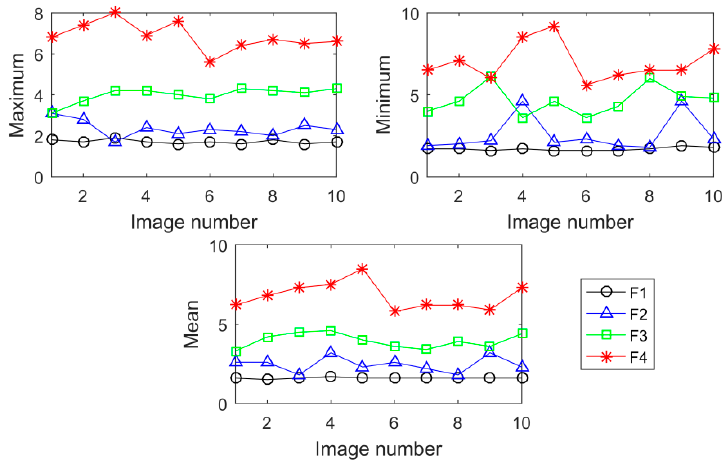
Figure 18. Comparison of temperature difference data.